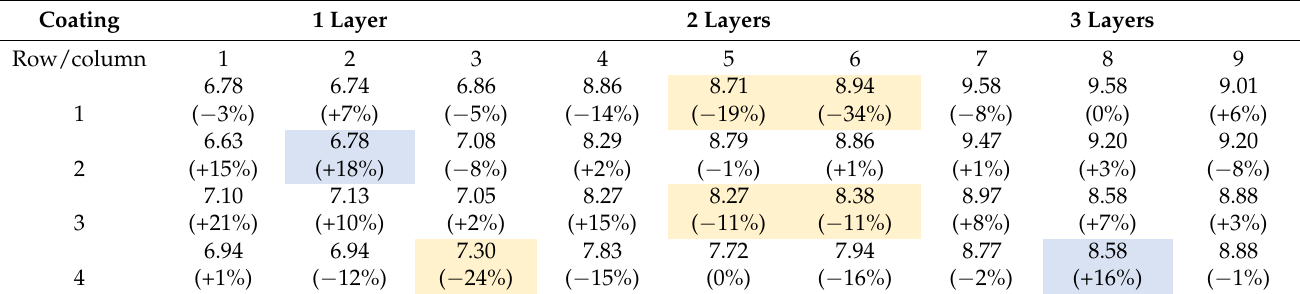
Table 5. Comparison of calculated logarithms of the impedance moduli Z 0.1 ( Ω cm 2 ) at 36 test points on the basis of two correlation relationships shown in Figure 15; the percentage difference between the measured and calculated logarithm of the impedance modulus is given in